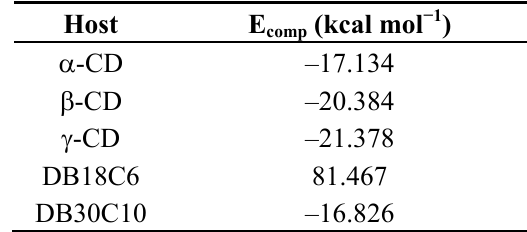
Table 4. Molecular modelling results of interaction energies ( E optimal configurations of (1:1) promethazine/CDs and promethazine/dibenzocrown ether inclusion